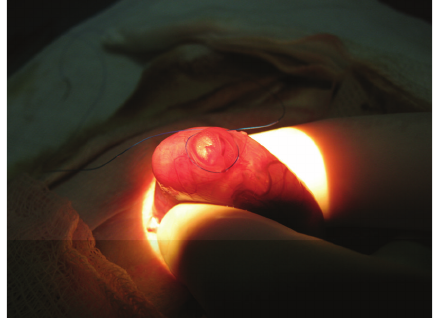
Figure 1: Exposure of the fetal head.